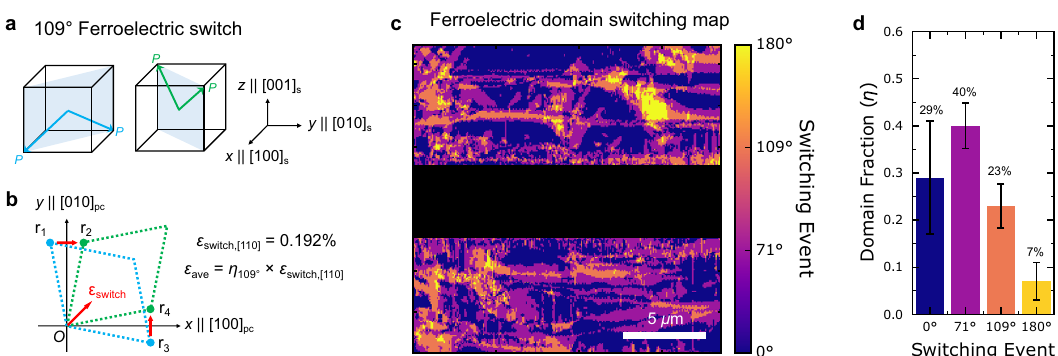
Fig. 3 Local shear strains arising from 109° polarization switching in PMN-PT. a Polarizations within the (110) s (substrate) plane, blue, and the ( (cid:1) 110) s plane, green, are associated with shear distortion in the (001) pc plane. b indicated by the blue and green dashed frame. The corresponding shear strain arising from a 109° polarization switching can be calculated based on the coordinates of points r i ( i = 1,2,3,4), where the translation from r 1 to r 2 results in a 0.192% shear strain per unit cell. This is then scaled by the fraction of ferroelectric domains that undergo a 109° switch ( η seen by the device. c PFM switching map that allows us to experimentally determine η switching ( + 4 kV cm -1 ) and after switching ( − 4 kV cm − 1 ) and calculating the 3D switching angle per pixel. The directions of the ferroelectric vectors were determined by combining in-plane and out-of-plane piezoresponse patterns before and after rotating the sample by 90° to allow for the determination of in-plane directionality. The full data set is shown in Sup. Fig. S5. d Histogram of the switching events from 14 composite images, with standard deviations shown as error bars. The analysis indicates that 23% ± 4% of the domains undergo 109°